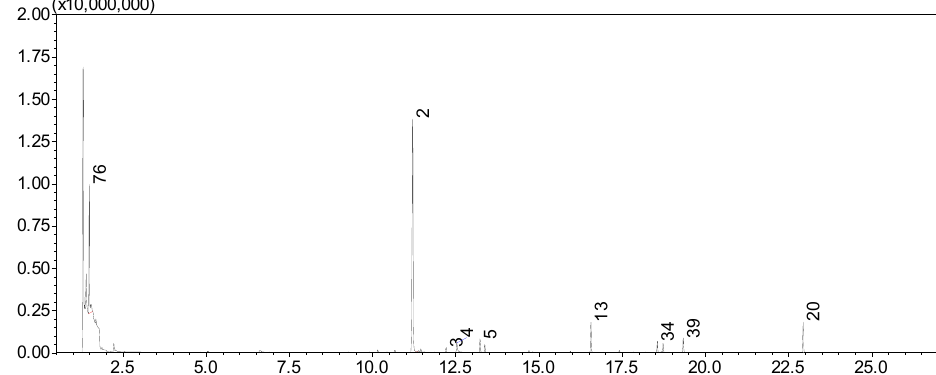
Figure 2. Total ion chromatogram of VOCs collected from an L flower in the W2 population. Numbers correspond to the chemical compounds in Table 2. Peaks for major compounds with amounts > 1% are labeled.